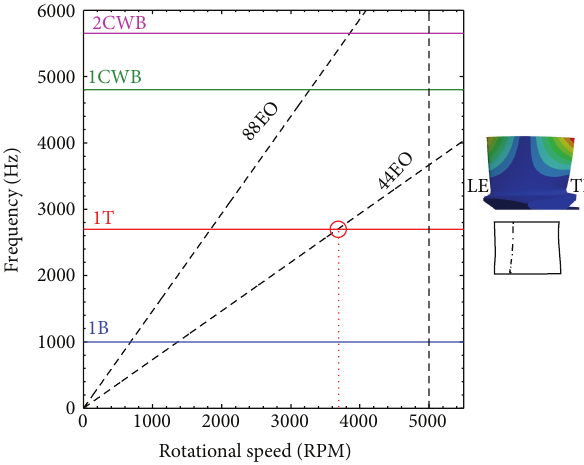
Figure 3: Campbell diagram for Rotor 2 including mode shape and nodal line for the 1T vibratory